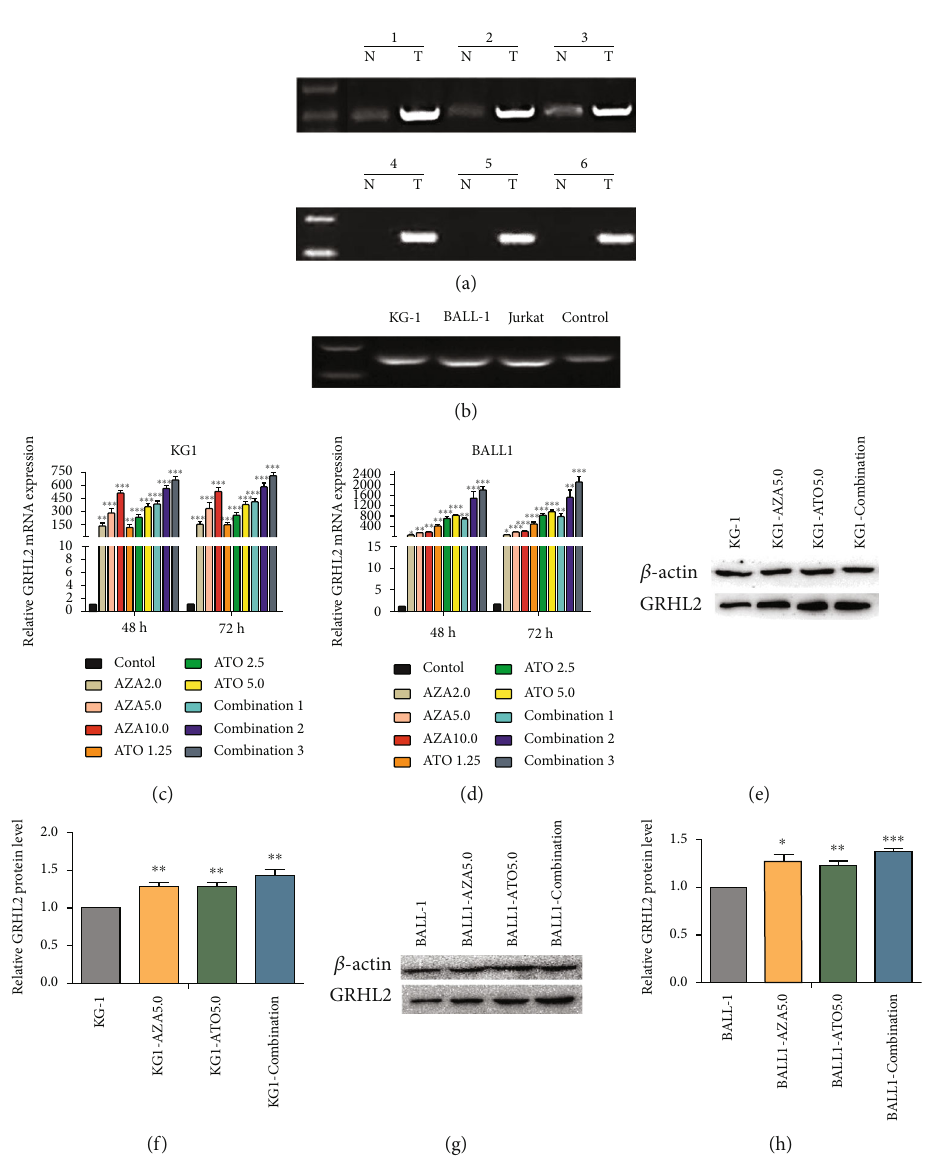
Figure 3: The methylation levels of GRHL2 gene promoter region in patients with acute leukemia and cell lines. (a) The methylation level of the GRHL2 promoter region in acute leukemia patients. (b) The methylation level of GRHL2 promoter region in acute leukemia cell lines. (c, d) The mRNA levels of the GRHL2 in acute leukemia cell lines after the use of the cell demethylation drug arsenic trioxide and 5-azacitidine. (e – h) The protein levels of GRHL2 in acute leukemia cell lines after the use of the cell demethylation drug arsenic trioxide and